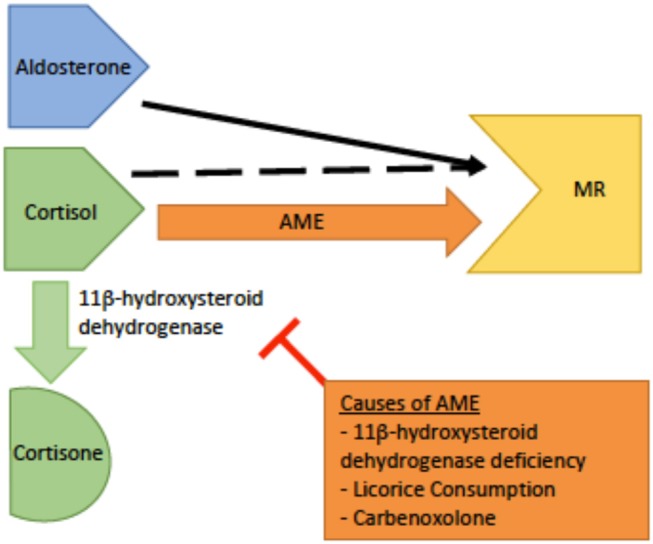
A schematic of the pathophysiology of apparent mineralocorticoid excess (AME). The dashed black arrow indicates normal binding of cortisol to the mineralocorticoid receptor (MR) with conversion to cortisone by 11β-dehydrogenase.The orange arrow indicates AME. In AME, deficiency or inhibition of 11β -dehydrogenase leads to increased levels of cortisol increased cortisol-MR binding, and subsequent hyperactivity of the MR.